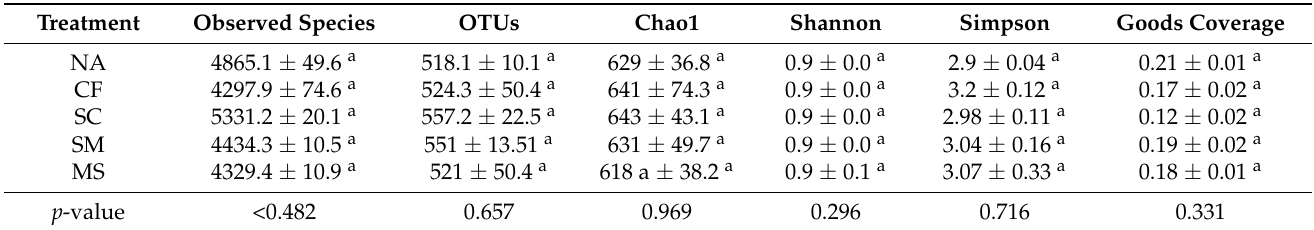
Figure 3. ( A ) amoA gene copy numbers of AOA and ( B ) AOB in calcareous soil under various fertilization practices. The different alphabets (c, a, bc and a) show significant difference at p < 0.05, while those with a common alphabet (a) show no significant difference (i.e., p > 0.05). NA = no fertilizer, CF = Chemical fertilizer, SC = inorganic fertilizer plus cow manure, SM = cow manure, and MS = corn stalk. Table 4. Diversity indices of ammonia-oxidizing archaea (AOA) at the similarity level of 97% under the influence of soil amendments.